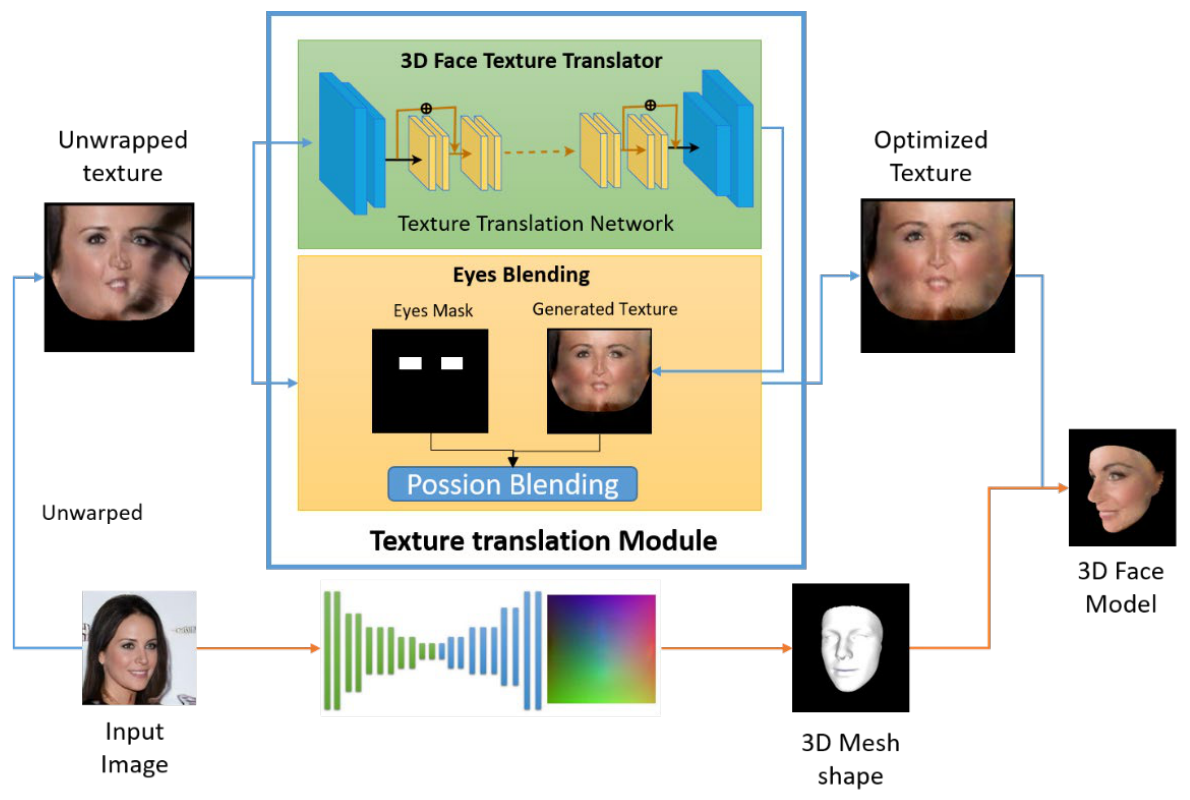
Figure 10. Application of the texture translator network in PRNet.